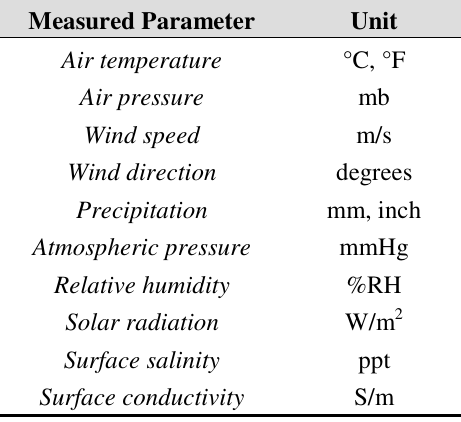
Table 3. Surface